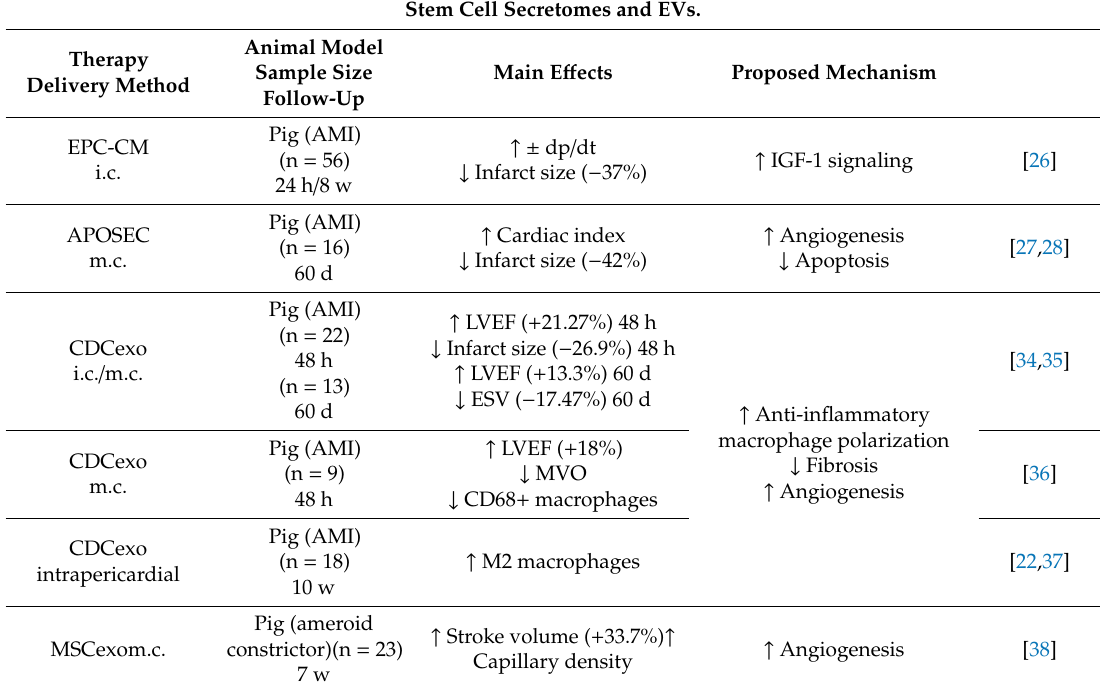
Stem Cell Secretomes and